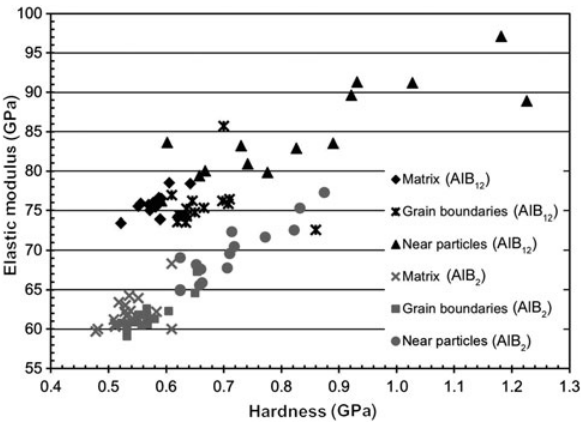
Figure 6 Elastic modulus as a function of hardness obtained by nanoindentation on different locations of the composites microstructure.